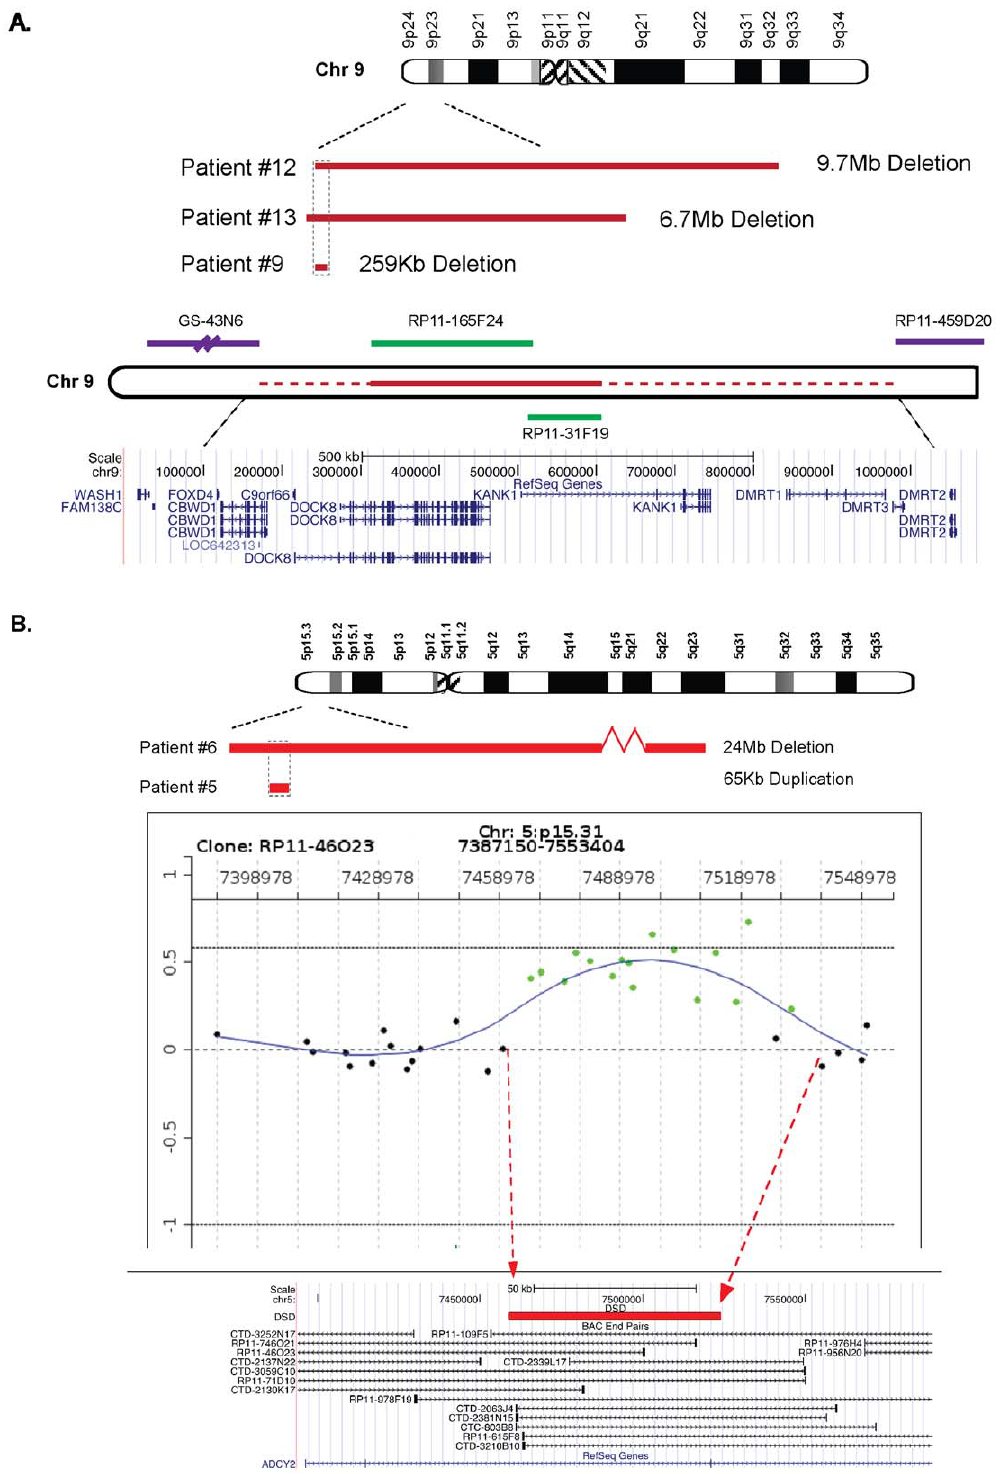
Figure 2. Overlapping Chromosomal Rearrangements in DSD patients. A . Delineation of a minimal human 9p sex reversal deletion. Schematic representation of the overlapping CMA detected 9p deletions in three unrelated 46,XY patients presenting with gonadal dysgenesis. A minimal common 260 Kb region was defined. Map showing the BAC clones covering the critical sex determination region and the normal flanking clones (RP11-459D20 and GS-43N6). A UCSC genome browser view ( May 2006 Human Assembly) of the RefSeq genes encompassing the minimal 9p24.3 sex-reversing region was presented. B . Structural variation shared by unrelated patients presenting with distinct urogenital defects, may affect master regulator(s) of human genital development. A common genomic interval of 65 Kb in the cytoband 5p15.31 was deleted in patient 6 with genital ambiguity and duplicated in patient 5 with hypospadias. CMA detection of the 65 Kb duplication in patient 5 and a UCSC genome browser view ( May 2006 Human Assembly) of the encompassed ADCY2 gene were presented.